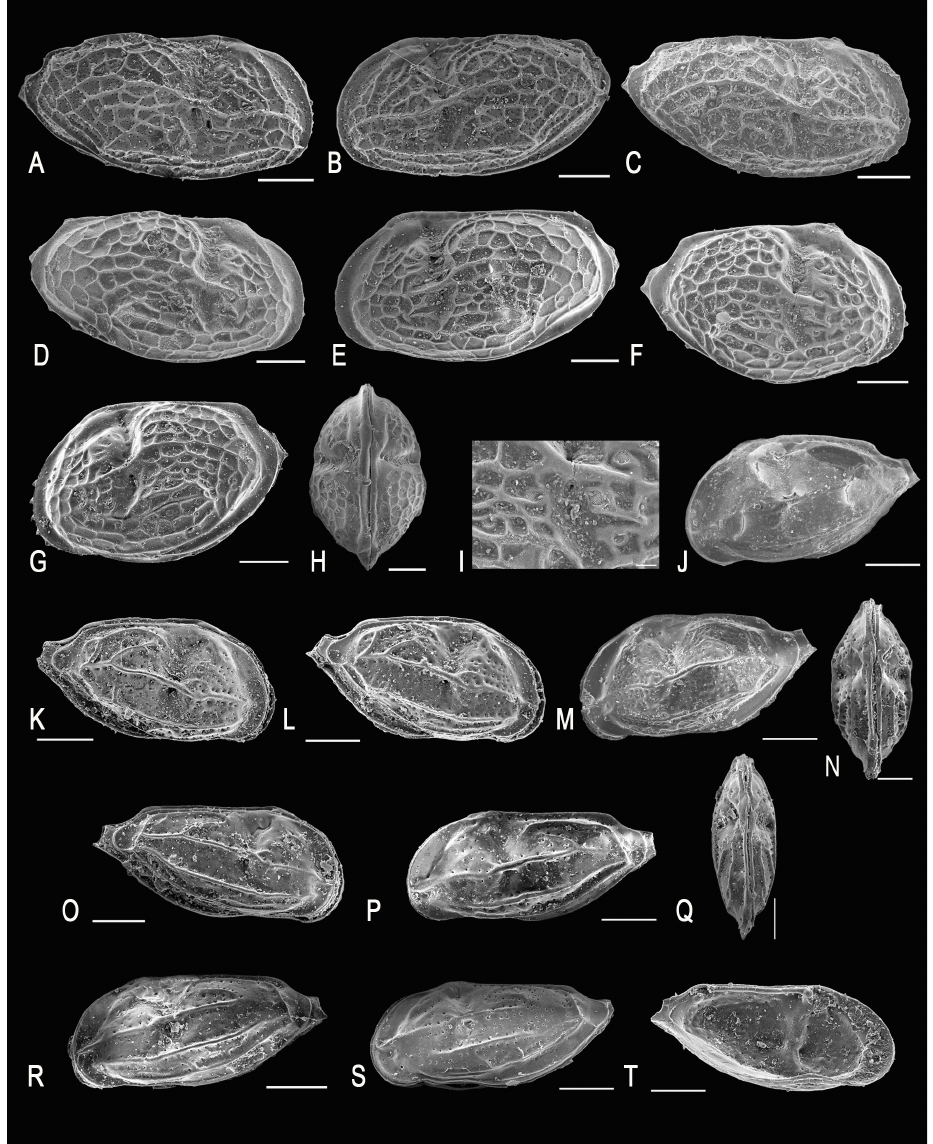
Fig. 6. Holocene ostracods from Samut Sakhon Province, Central Thailand. A–C . Neomonoceratina iniqua (Brady, 1868). A . Valve, male, right lateral view, SUT-20SS-C097. B . Valve, male, left lateral view, SUT- 20SS-C095. C . Valve, male, right lateral view, SUT-20SS-C093. – D–I . Neomonoceratina rhomboidei (Brady, 1968). D . Carapace, male, right lateral view, SUT-20SS-C113. E . Carapace, male, right lateral view, SUT- 20SS-C120. F . Carapace, female, right lateral view, SUT-20SS-C099. G . Carapace, female, left lateral view, SUT-20SS-C107. H . Carapace, female, dorsal view, SUT-20SS-C114. I . Sieve pores. – J . Neomonoceratina columbiformis Kingma, 1948. Carapace, left lateral view, SUT-20SS-C181. – K–N . Neomonoceratina mediterranea mediterranea (Ruggieri, 1953). K . Carapace, female, right lateral view, SUT-20SS-C167. L . Carapace, female, right lateral view, SUT-20SS-C173. M . Carapace, female, left lateral view, SUT- 20SS-C164. N . Carapace, female, dorsal view, SUT-20SS-C174. – O–T . Neomonoceratina mediterranea malayensis Zhao & Whatley, 1988. O . Carapace, male, right lateral view, SUT-20SS-C159. P . Carapace, male, left lateral view, SUT-20SS-C157. Q . Carapace, male, dorsal view, SUT-20SS-C161. R . Carapace, male, left lateral view, SUT-20SS-C152. S . Carapace, male, left lateral view, SUT-20SS-C141. T . Valve, male, internal view of left valve, SUT-20SS-C160. Scale bars = 1